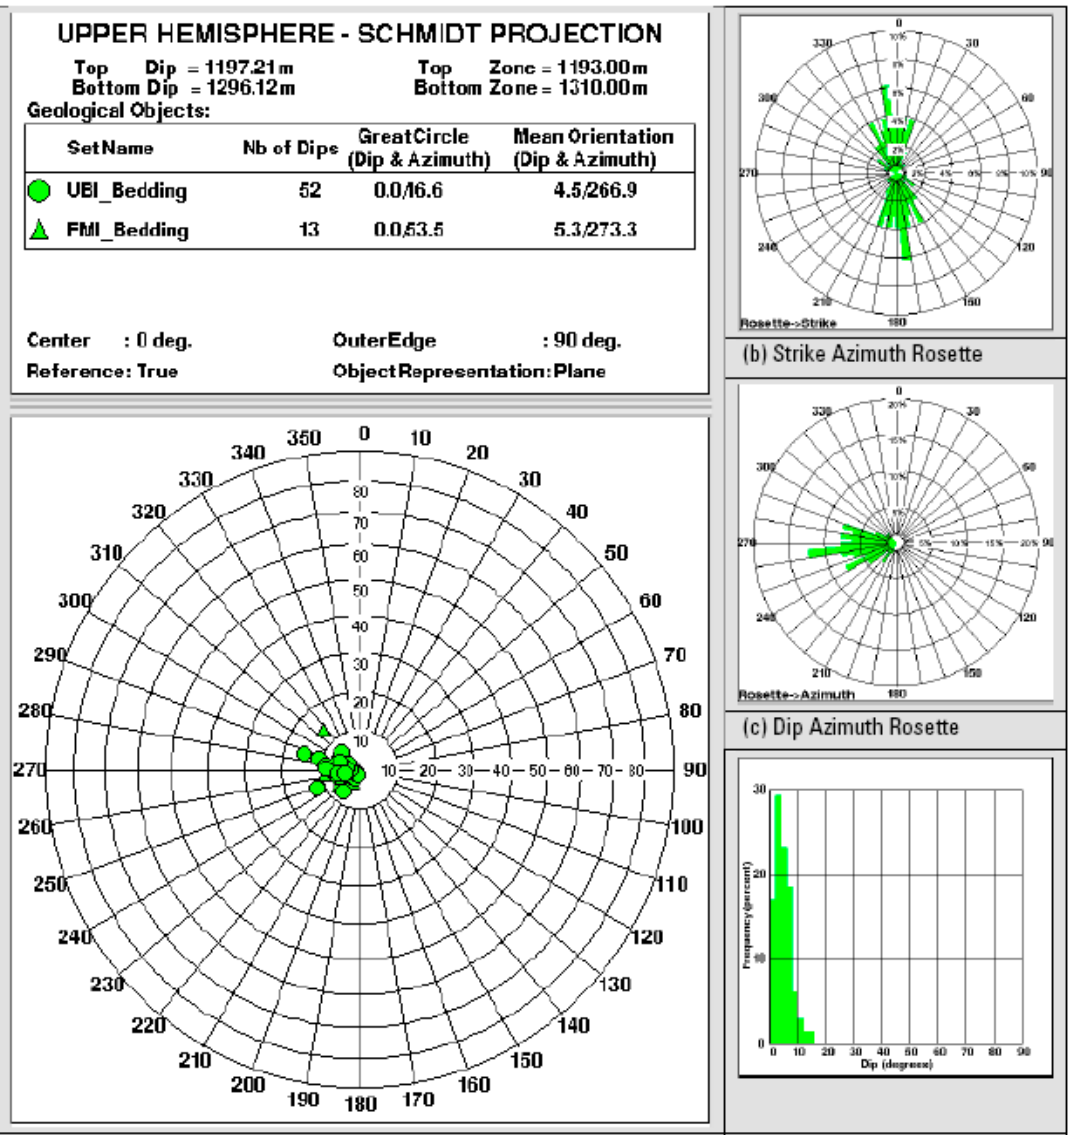
Figure 12. Statistical plots of FMI and UBI bedding dips identified and picked up from the FMI and UBI images acquired across 1194.2–1310 m interval of the Well MD-8.